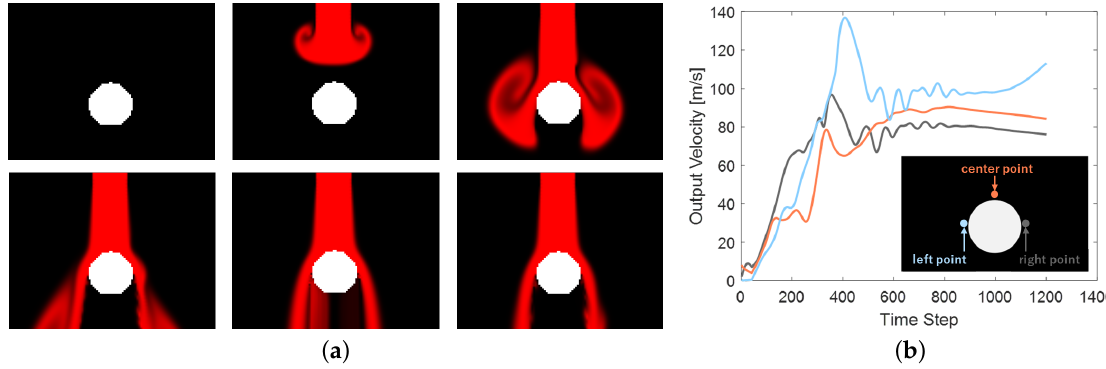
Figure 3. ( a ) Fluid simulation for 1 finger and ( b ) the velocity measured in the fluid simulation on the left, center, and right parts of the middle